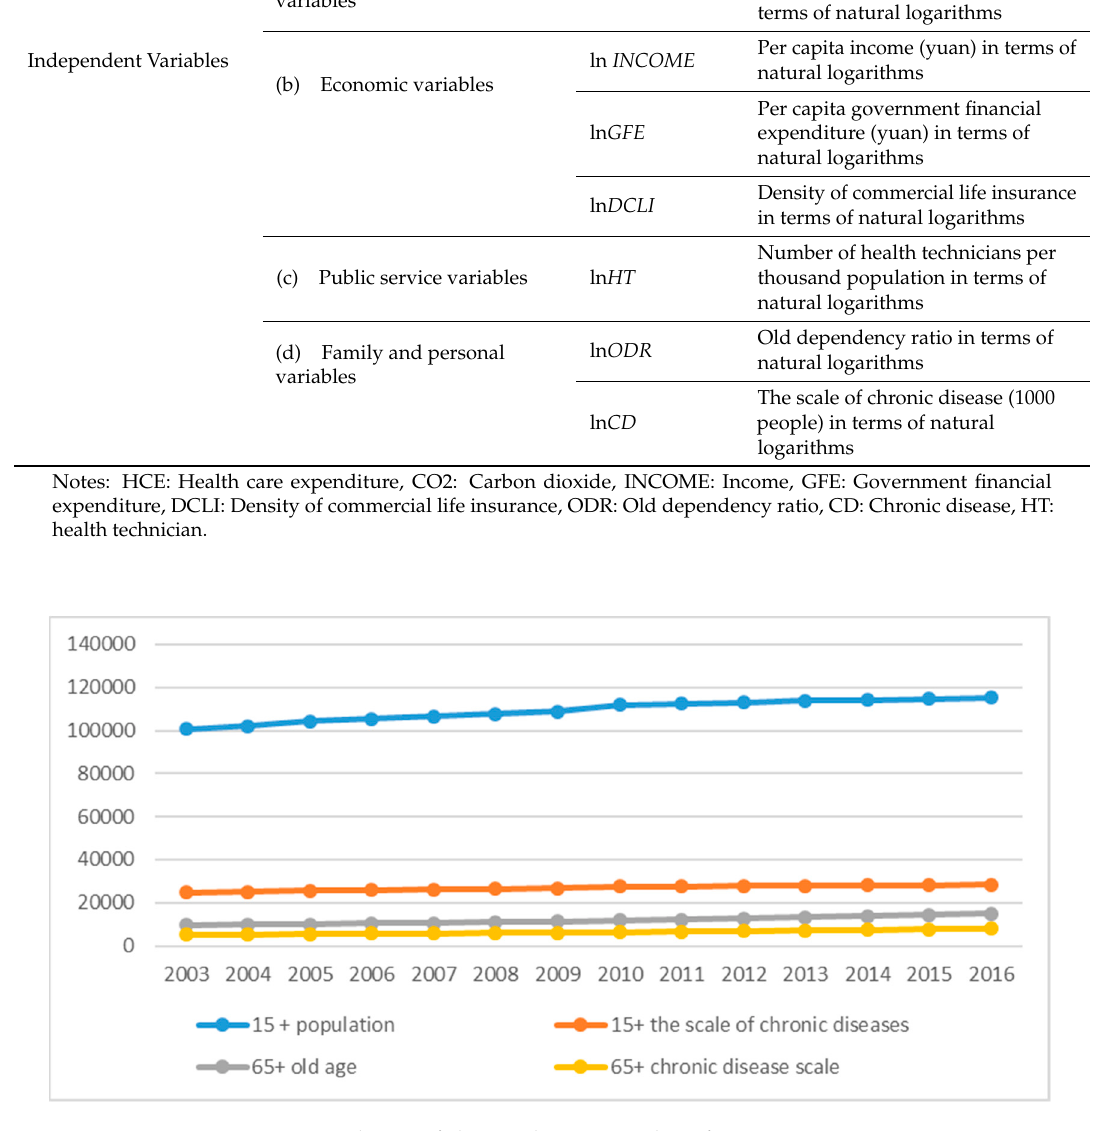
Figure 1. Evolution of chronic diseases in China from 2003 to